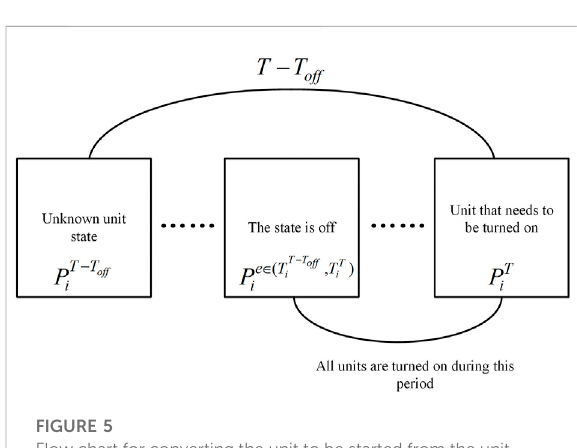
FIGURE 5 Flow chart for converting the unit to be started from the unit to be